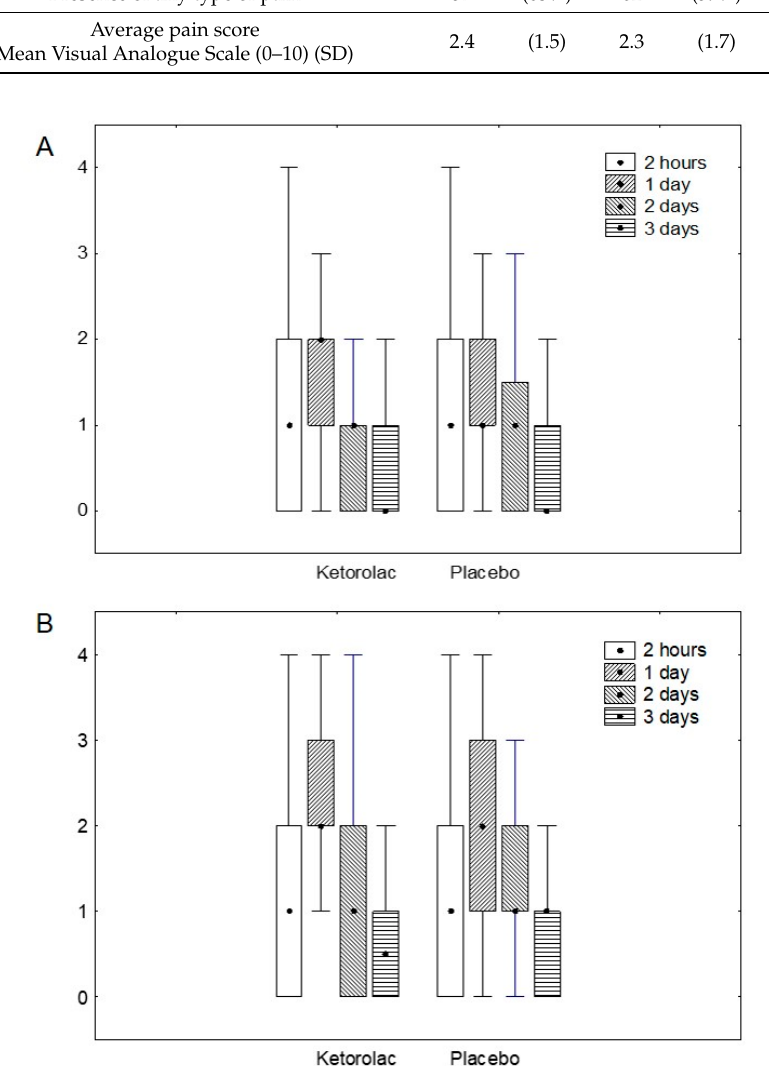
Figure 2. Acute pain score on a simple verbal scale (0 to 4) at rest ( A ) and movement ( B ) after surgery. p > 0.05 for all the comparisons. Pain scores are expressed as median, interquartile range (25–75), and range.